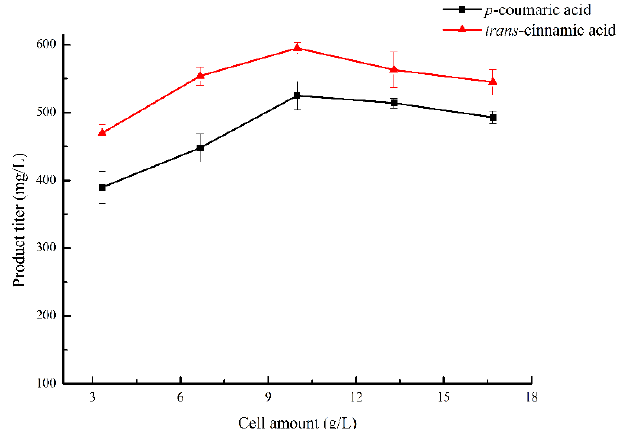
Figure 7. Effect of cell amounts on conversion of L-Phe and L-Tyr to trans -cinnamic acid and p - coumaric acid by E. coli BL21(DE3)/pETDuet-1- RgPAL . Reaction conditions: Temperature: 42 °C; L-Phe conversion time: 24 h and L-Tyr conversion time: 20 h Medium: L-Phe in pH 10 20 mM Glycine-NaOH and L-Tyr in pH 11 20 mM Glycine-NaOH; L-Phe and L-Tyr 1 mg/mL.